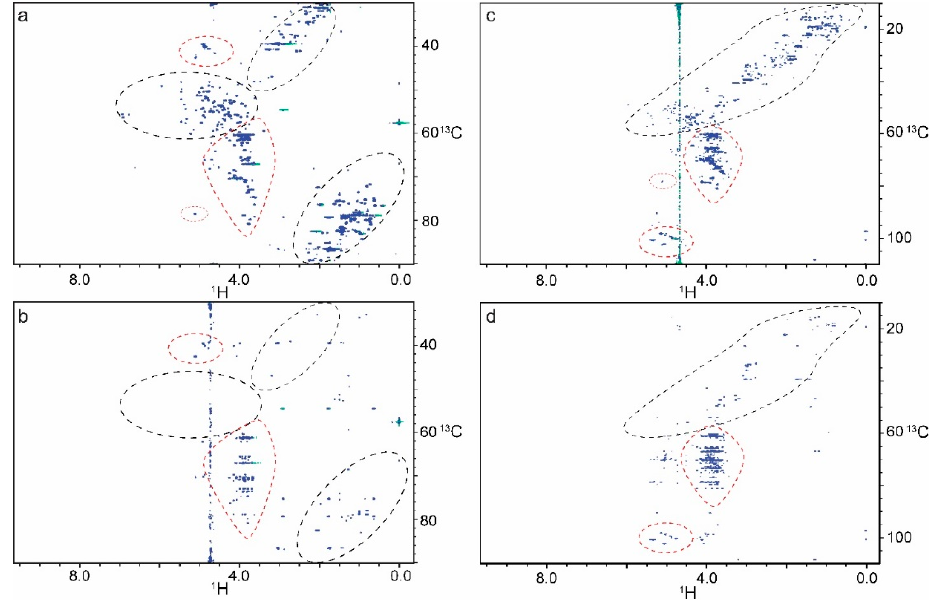
Figure 1. Comparison of 1 H- 13 C HSQC and HSQC-TOCSY spectra of RNase B Man 5 and Man 9 . ( a ) HSQC spectrum of 0.3 mM RNase B Man 5 contains peaks for both protein (black circles) and glycans (red circles). RNase B Man 5 anomeric protons (upper red circle) are folded in the 13 C dimension and range from 98–103 ppm. ( b ) An HSQC-TOCSY with a 90 ms mixing time of RNase B Man 5 takes advantage of the longer glycan T 2 , so that the glycans peaks are retained while the protein peaks are greatly reduced. Similarly, an HSQC of 0.6 mM RNase B Man 9 ( c ) shows peaks for both protein and glycan, while in the HSQC-TOCSY experiment ( d ) mostly glycan peaks are